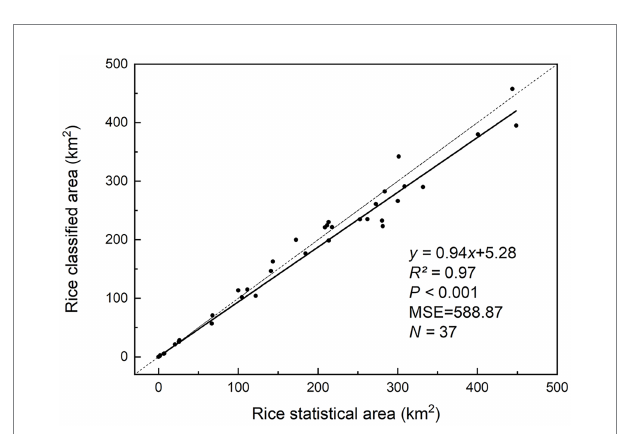
FIGURE 9 Correlation between MPHO-DPSAR derived results and the statistics of rice fields area.